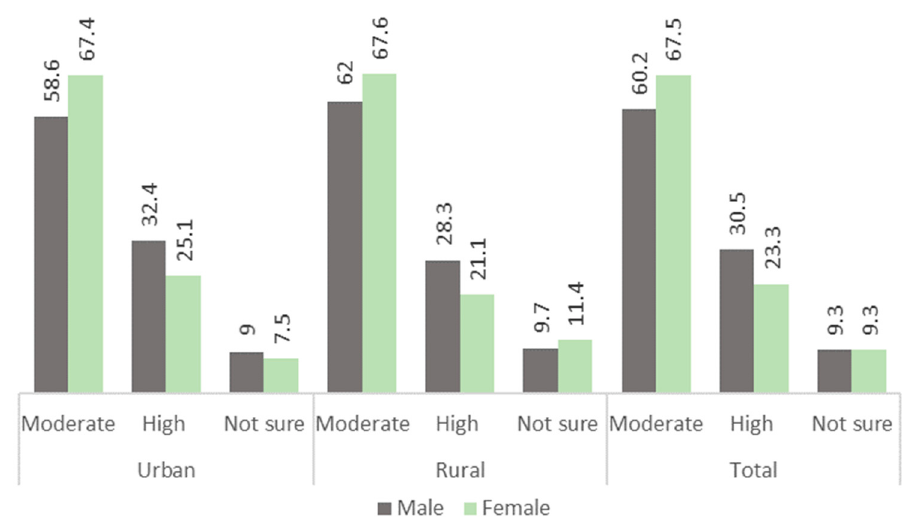
Figure 2. Prevalence of moderate- and high-risk drinking in past 2 weeks ( n = 3779).